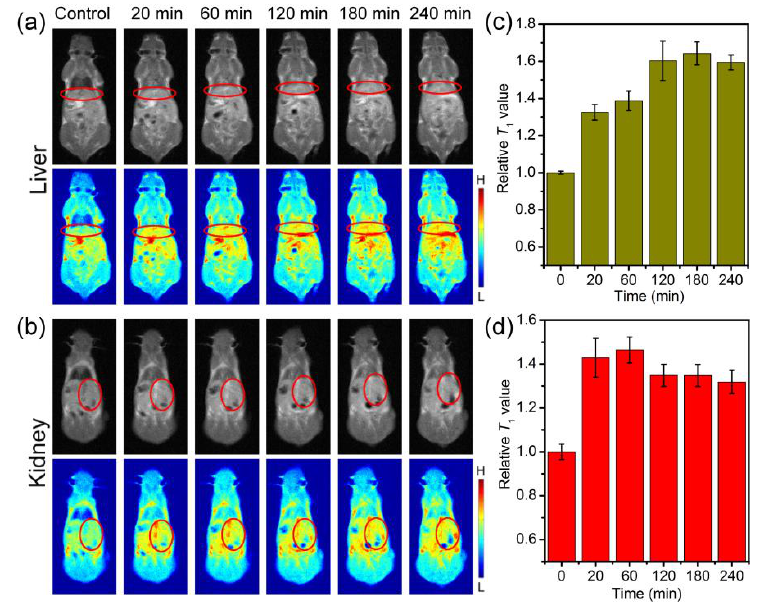
Figure 6. In vivo T 1 -weighted MR images of mice ( a ) liver and ( b ) kidney (selected area) collected before (control group) and after intravenous injection of Fe 3 O 4 -PMAA-PTTM nanoparticles at different time points, and the corresponding relative T 1 -weighted signals extracted from ( c ) liver and ( d ) kidney sites.